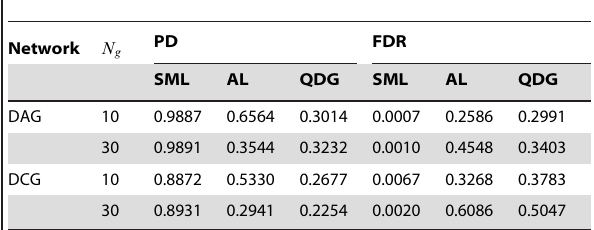
Table 1. Performance of SML, AL and QDG algorithms.